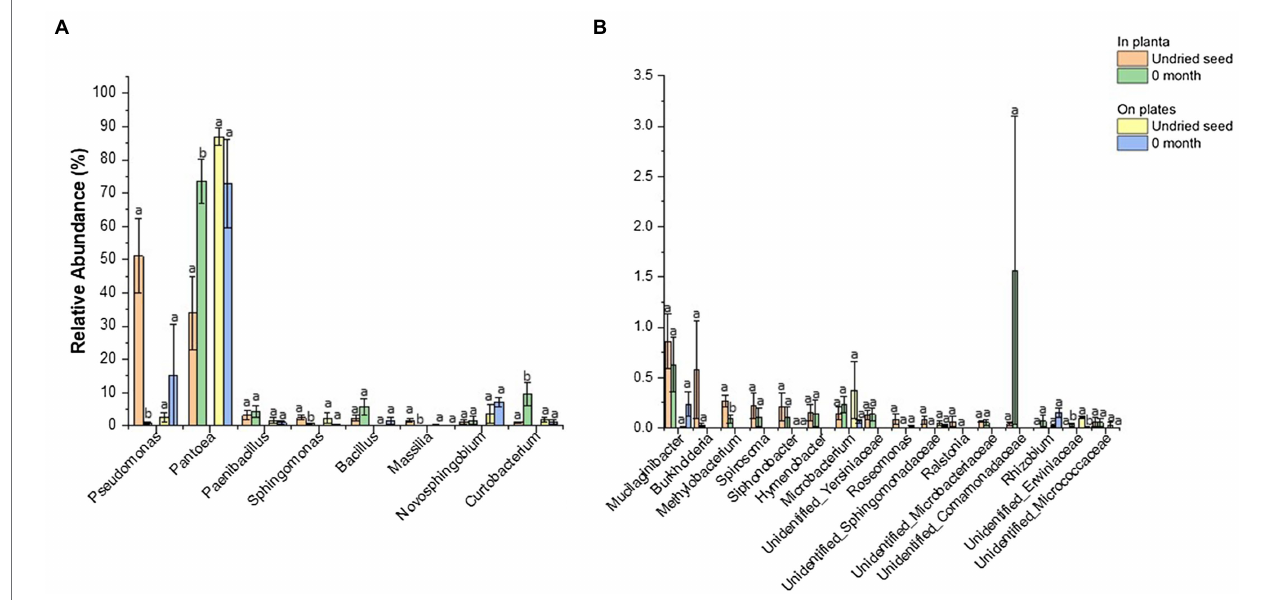
FIGURE 6 | Comparison of relative abundance of bacterial genera detected in undried seed and dried seed (0 month) in planta and on plates dataset. The abundance threshold was set based on in planta dataset ( A ) >1% and ( B ) <1% and >0.1% for statistical analysis. Significant differences (p ≤ 0.05) were determined by one-way ANOVA test and are indicated by different lowercase letters. Error bars show SE of mean